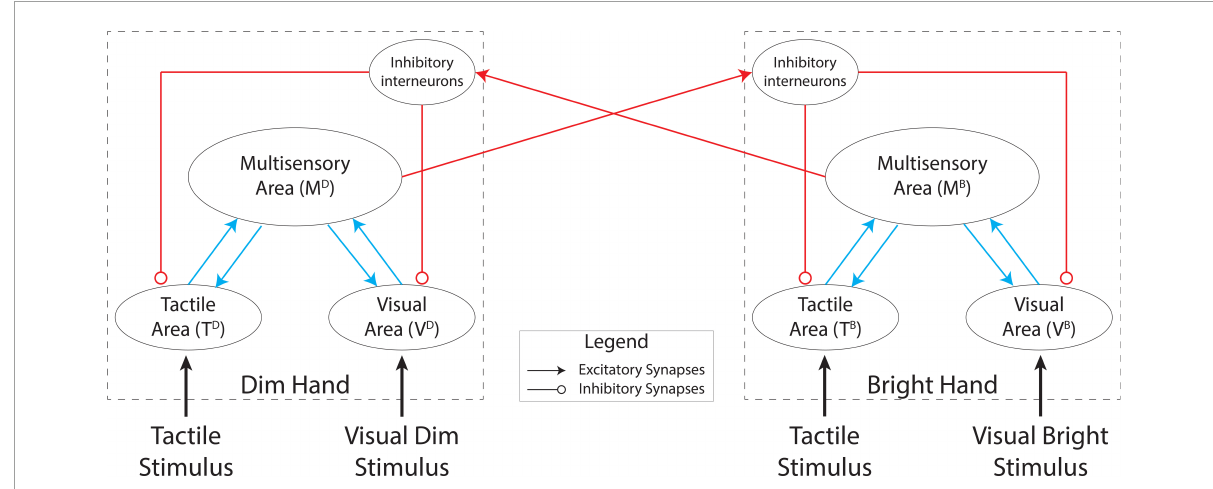
FIGURE2 Model architecture. Each hemisphere (dashed boxes) comprises a tactile area, a visual area, and a multisensory area. The unisensory areas reciprocally interact with the multisensory area in each hemisphere. The two hemispheres interact through excitatory projections from the multisensory areas to inhibitory interneurons which modulate activity in the unisensory